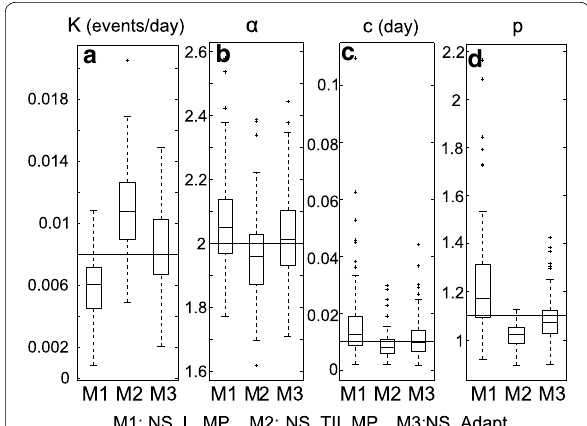
Fig. 3 Box plots of estimated model parameters for the Gaussian synthetic datasets. The box plots of model parameters estimated for the 100 synthetic catalogs using each of the models NS_L_MP, NS_ TII_MP and NS_Adapt are shown. The true values of the respective parameters are plotted as horizontal